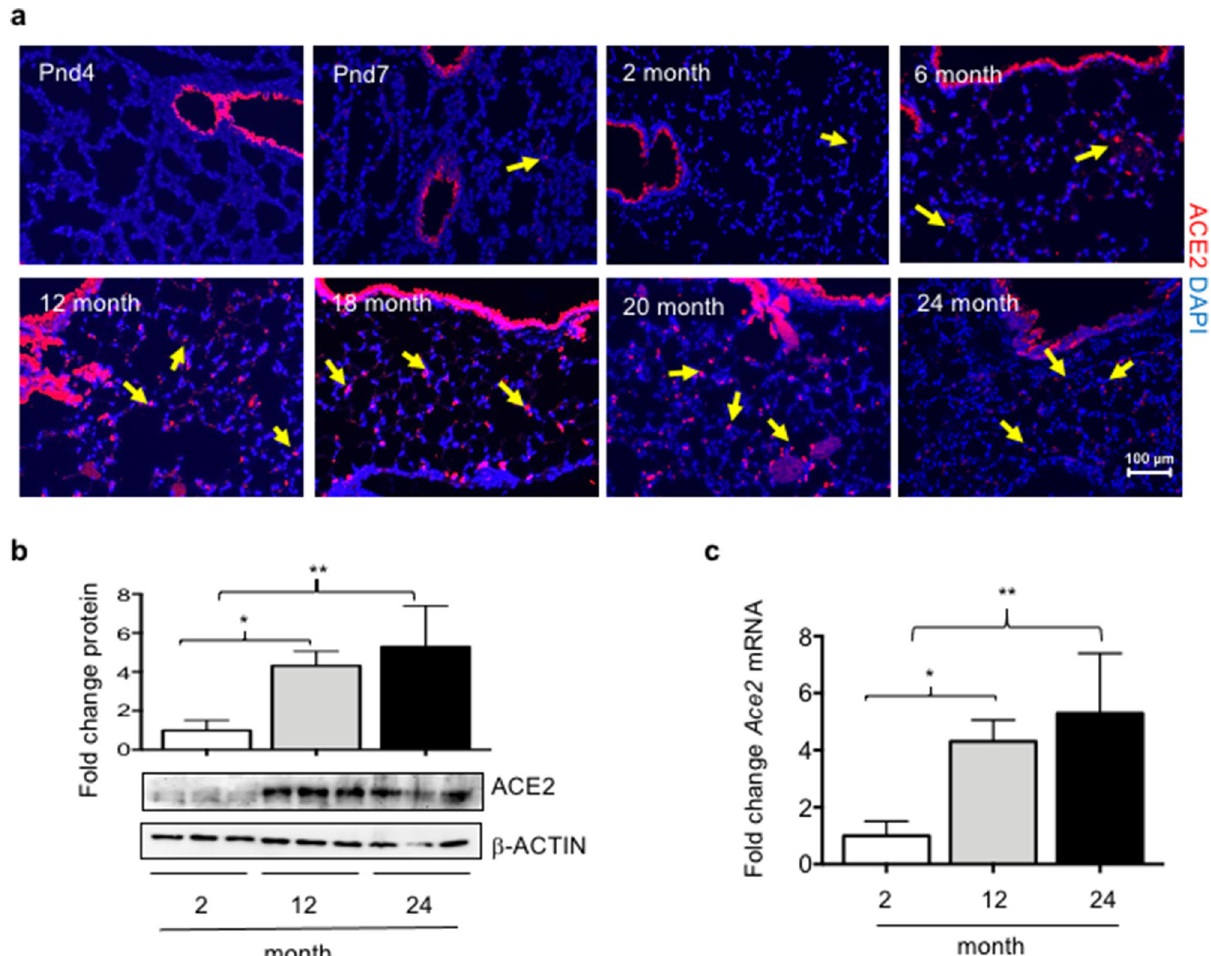
Figure 1. ACE2 expression changes in lung as mice age. ( a ) Lungs harvested from mice of different ages were stained for ACE2 (red) and counterstained with DAPI (blue). ACE2 was detected in airways of all mice and alveolar regions (yellow arrows). Bar = 100 mm. ( b ) Lungs homogenates prepared from 2-month, 12-month, and 24-month-old mice were immunoblotted for ACE2 and β-ACTIN as a loading control. Each lane represents an individual mouse. Band intensity of ACE2 to β-ACTIN was quantified and graphed as fold change relative to 2-month samples. Bars reflect mean ± SD graphed. ( c ) qRT-PCR was used to quantify Ace2 mRNA in total lung homogenates of 2-month and 24-month-old mice. Data is graphed as the fold change of Ace2 after normalizing to 18S RNA from 5 mice per group. Bars reflect mean ± SD graphed as fold change over 2-month values. Statistical significance is comparisons for all pairs using Tukey–Kramer HSD test, with *P ≤ 0.05; **P ≤